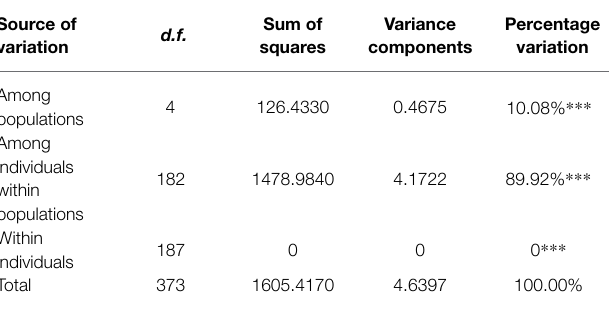
TABLE 4 | Analysis of molecular variance based on SSRs for populations of 189 genotypes.